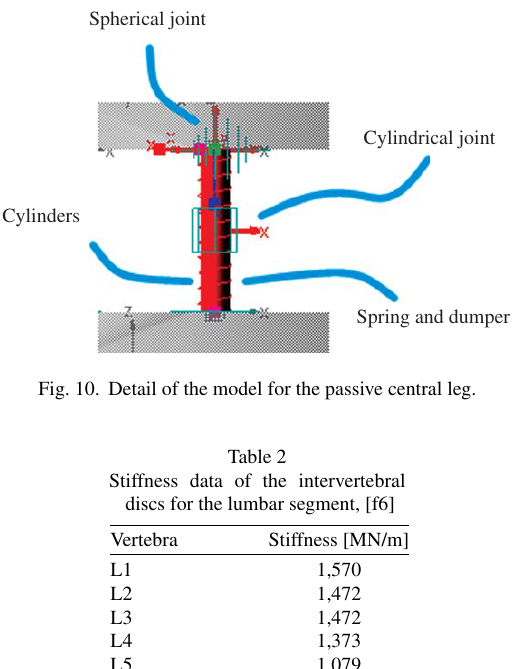
Fig. 9. Detail of the actuators model in a leg by two sliding bars.